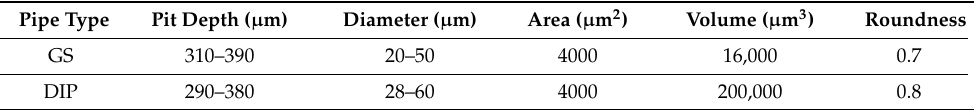
Table 4. A comparison of pitting features between GS and DIP pipes.